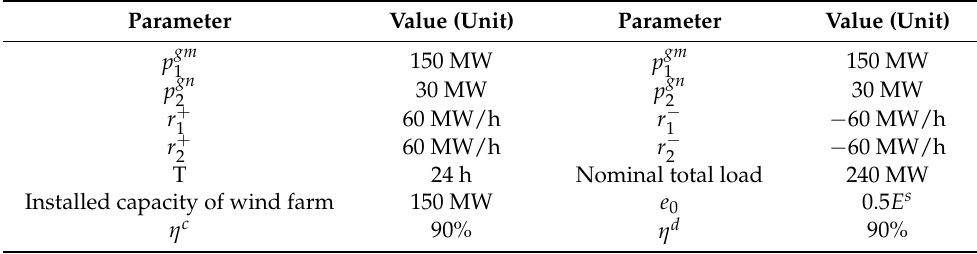
Figure 2. Load curve.